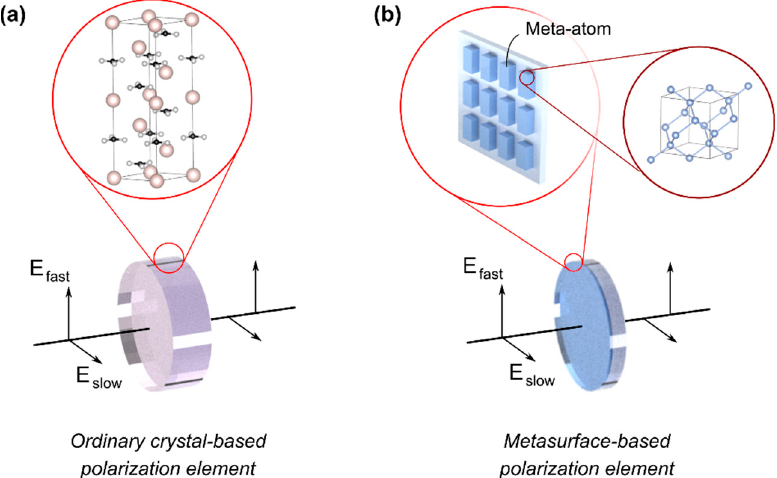
Figure 1. Ordinary vs. metasurface-based polarization-handling optical elements. Panel ( a ) schematically reports a calcite waveplate: the wave retardance is provided by the anisotropic response of electrons in the CaCO 3 crystal. Panel ( b ) illustrates a metasurface waveplate: the wave retardance is now dictated by the electromagnetic response of the meta-atoms, whose shape is engineered to produce the required polarization operation. As an example, the meta-atom is represented to be constituted of crystalline silicon. Notice that the metasurface thickness can be reduced to the order of the radiation wavelength.